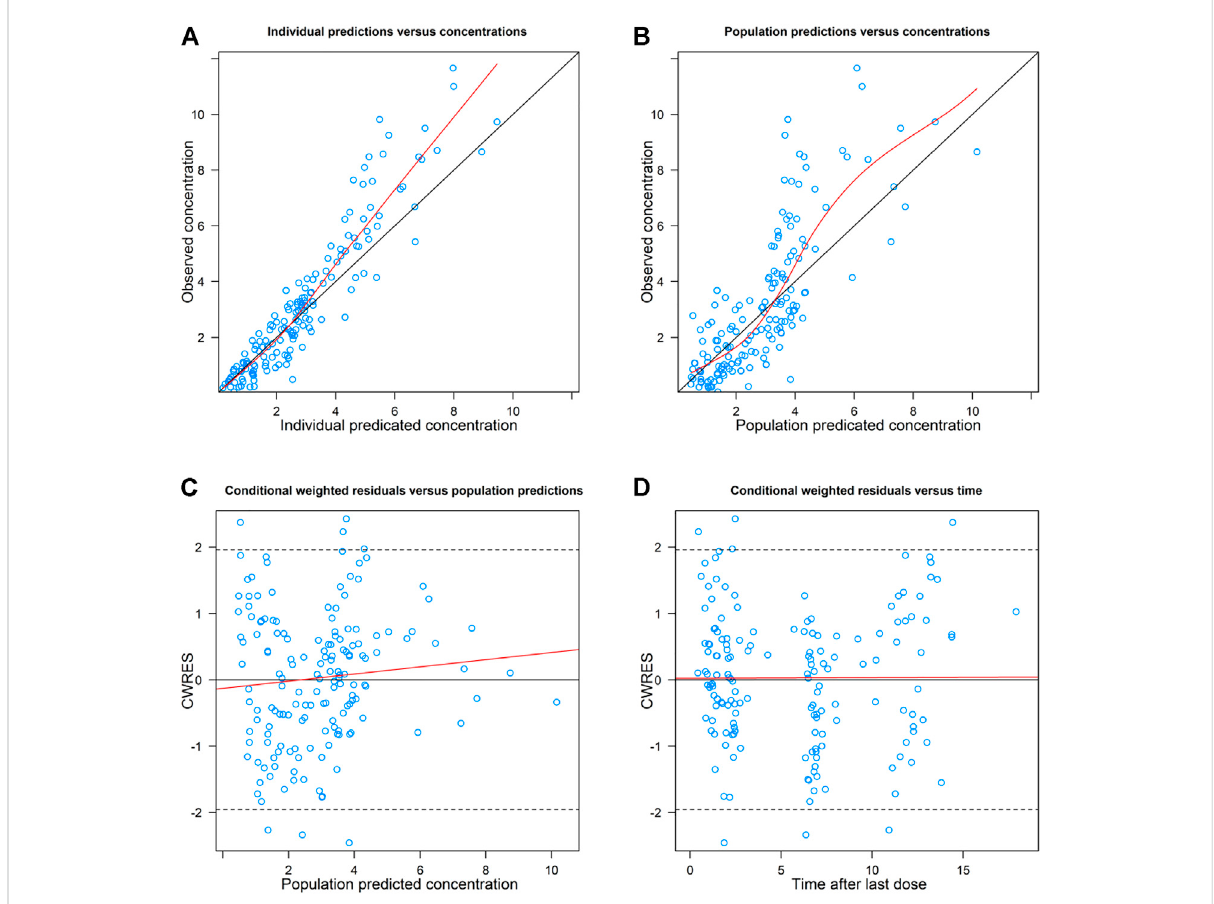
FIGURE 2 Goodness-of- fi t plots of the fi nal model. (A) Observed concentration (DV) versus individual predicted concentration (IPRED); (B) DV Versus populationpredictedconcentration(PRED); (C) conditionalweightedresiduals(CWRES)versusPRED;and (D) CWRESVersustimeafterthelastdose. The red solid lines in (A) and (B) are identity lines, and the red solid lines in (C) and (D) are zero